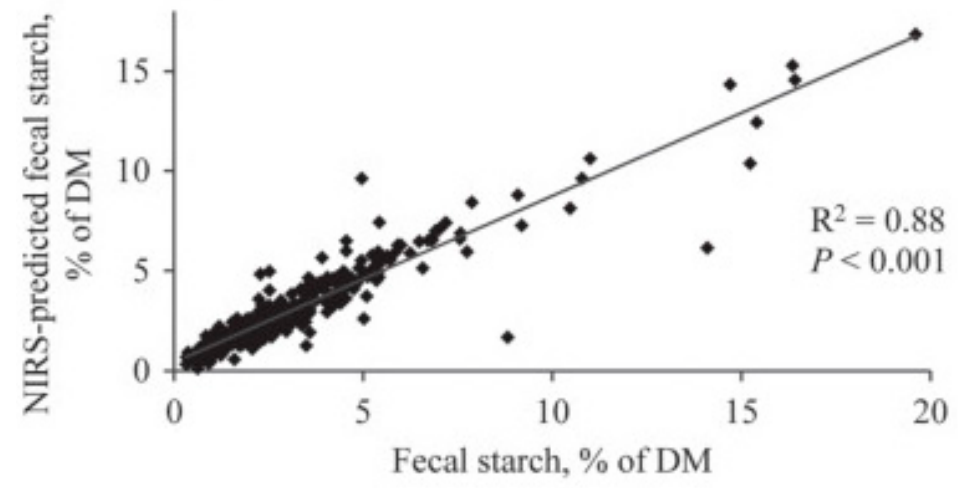
Figure 4. Regression plot of fecal starch content (% of DM) determined by wet chemistry and near- infrared spectroscopy (NIRS), reproduced from [86], with permission from ELSEVIER,